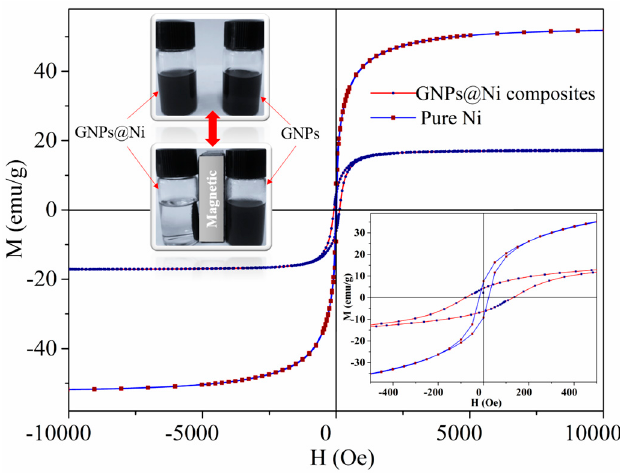
Figure 5. Magnetization hysteresis loops of GNPs@Ni composites and pure Ni nanoparticles.